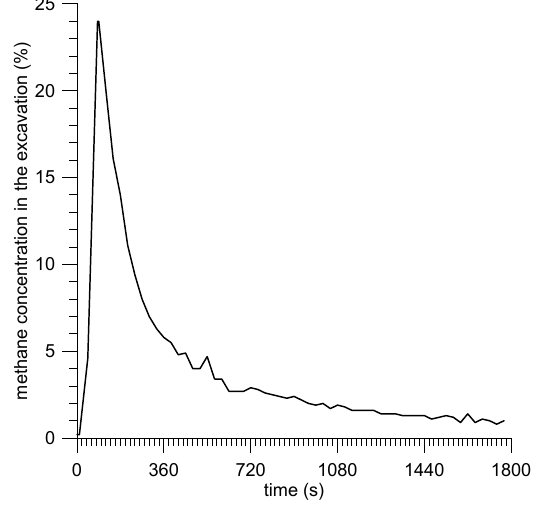
Figure 23. Methane concentration in the excavation after Budryk outburst.